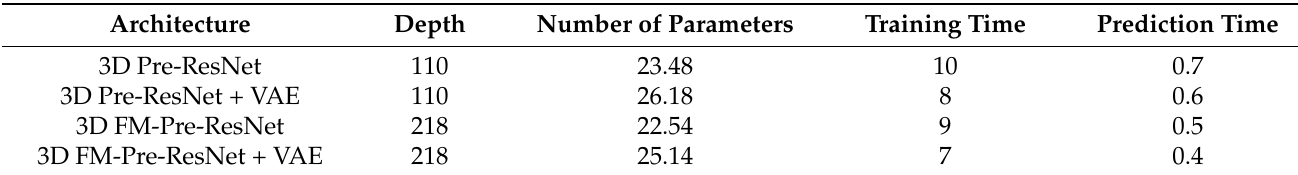
Table 5. Comparison of depth, number of parameters ( × 10 6 ), training times per epoch (min), and prediction time (s) for one volume for different architectures: Pre-ResNet, 3D Pre-ResNet + VAE, FM-Pre-ResNet, and FM-Pre-ResNet +